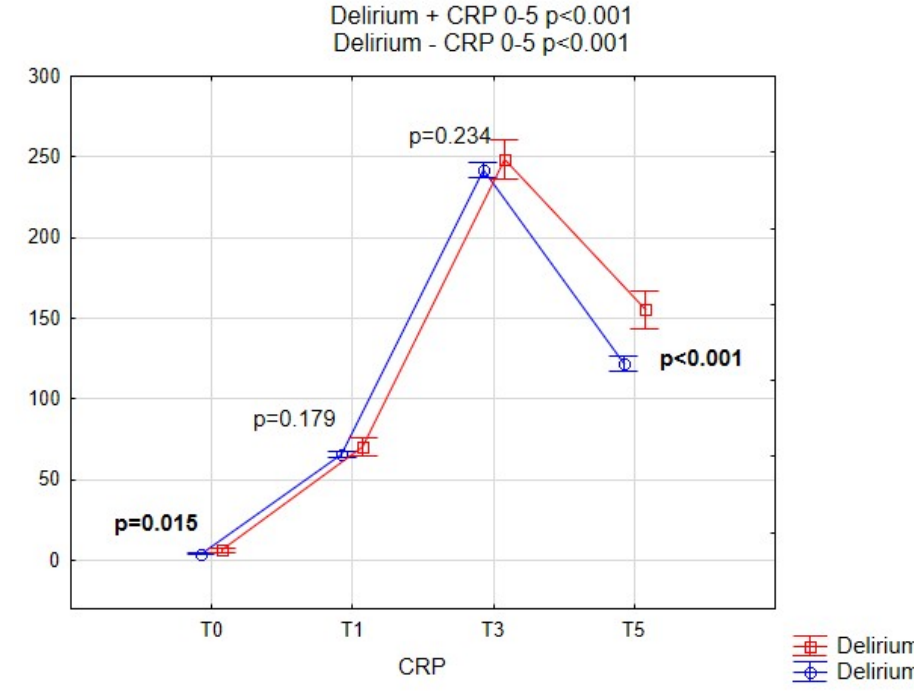
Figure 5. Pre-operative and post-operative CRP values for patients with and without POD. CRP, C-reactive protein; POD, Postoperative delirium.